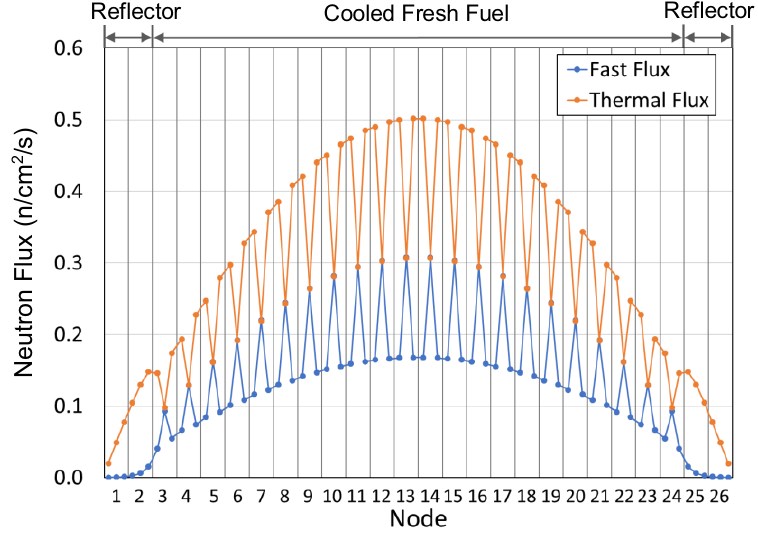
Figure 3. Heterogeneous, Steady-state Neutron Flux